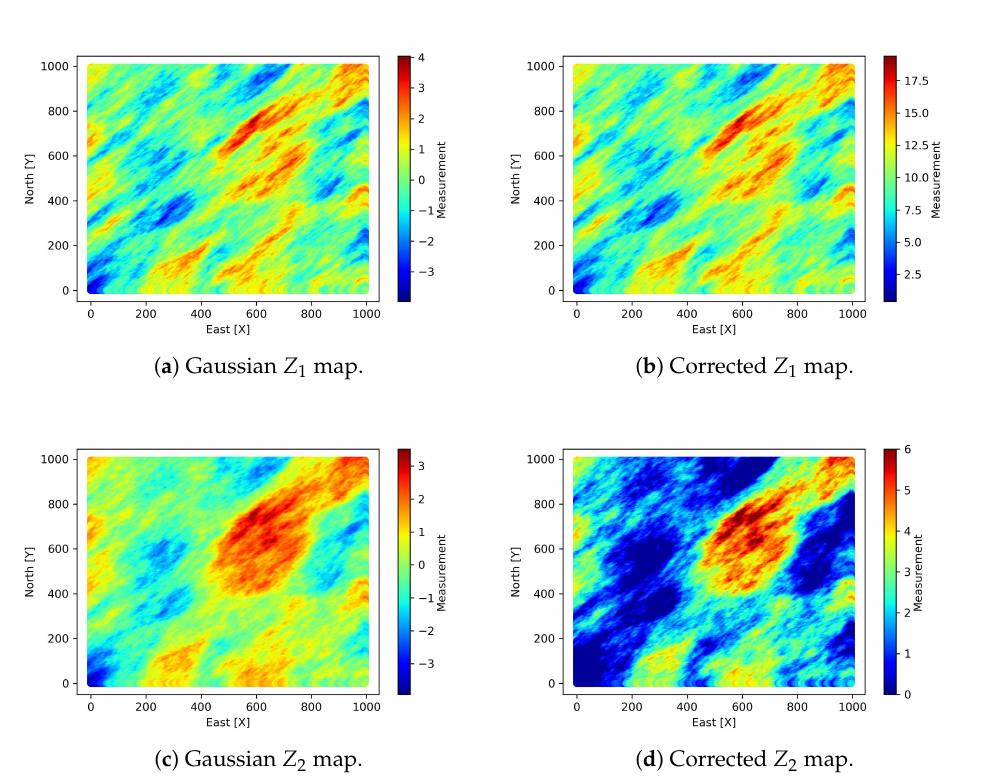
Figure 3. Maps of Z 1 and Z 2 with Gaussian sequential simulation and corrective affine